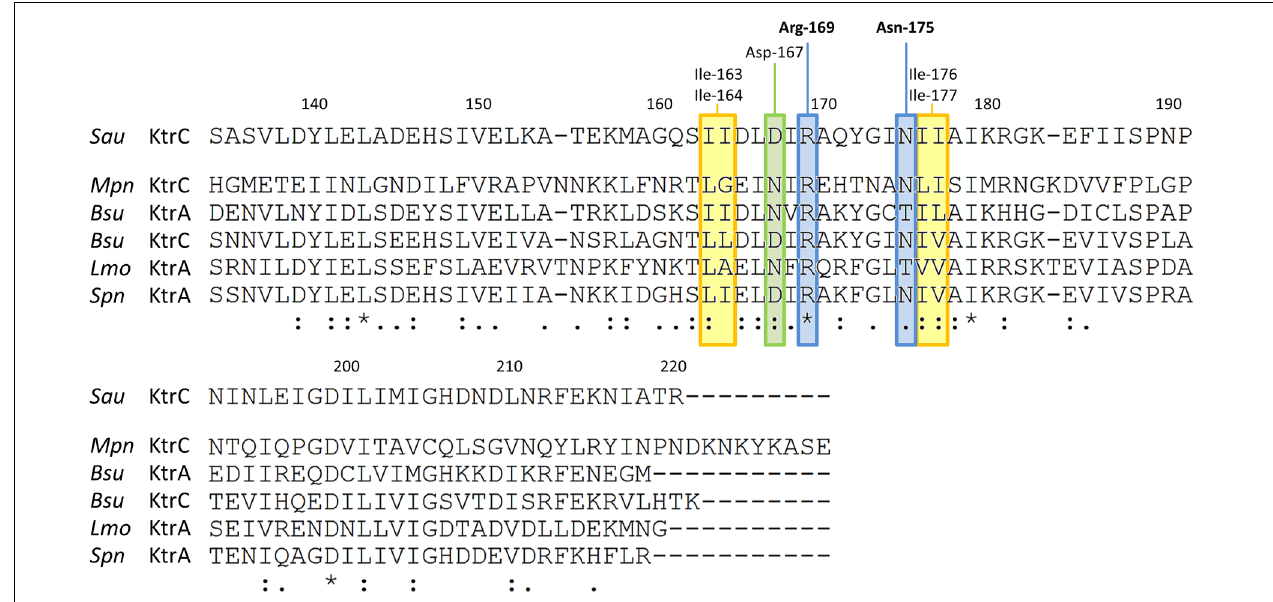
FIGURE 4 | Alignment of the c-di-AMP-binding regions in RCK_C domains of potassium uptake proteins. The C-terminal parts of different KtrC/ KtrA proteins were aligned to the experimentally identified c-di-AMP binding site of Staphylococcus aureus ( Sau ) KtrC (Kim et al., 2015). Residues responsible for c-di-AMP binding are highlighted: Arg-169 and Asn-175 (blue), which directly interact with c-di-AMP are conserved in M. pneumoniae KtrC; Asp-167 (green), which also forms a direct hydrogen bond with c-di-AMP is replaced by Asn which is also known to form hydrogen bonds, Ile-163/Ile-164 and Ile-176/Ile-177 (in yellow), which form the hydrophobic patch are well conserved in bacteria. Mpn Mycoplasma pneumoniae, Bsu Bacillus subtilis, Spn Streptococcus pneumoniae, Lmo Listeria monocytogenes . (cid:63) identical amino acids, : similar amino